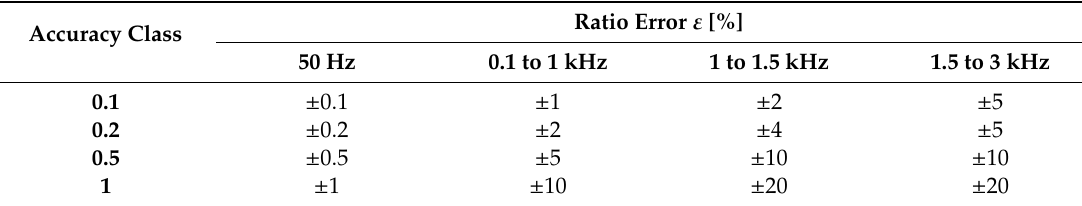
Table 2. Ratio error for each accuracy class and for di ff erent range of